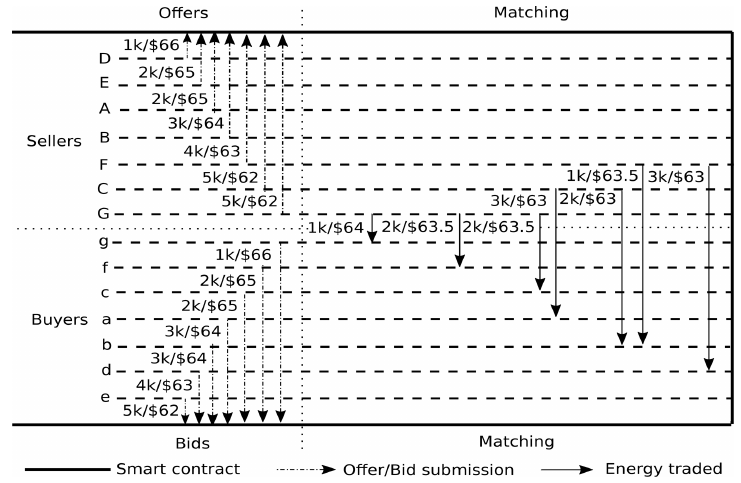
Figure 6. Smart contract execution of energy double auction. Energy sellers/buyers submit their offer/bid (amount of energy in MWh and cost per unit in $/MWh) to the smart contract which matches sellers and buyers using a double auction mechanism. The matching process determines the amount and cost of energy to be exchange between seller/buyer pairs.